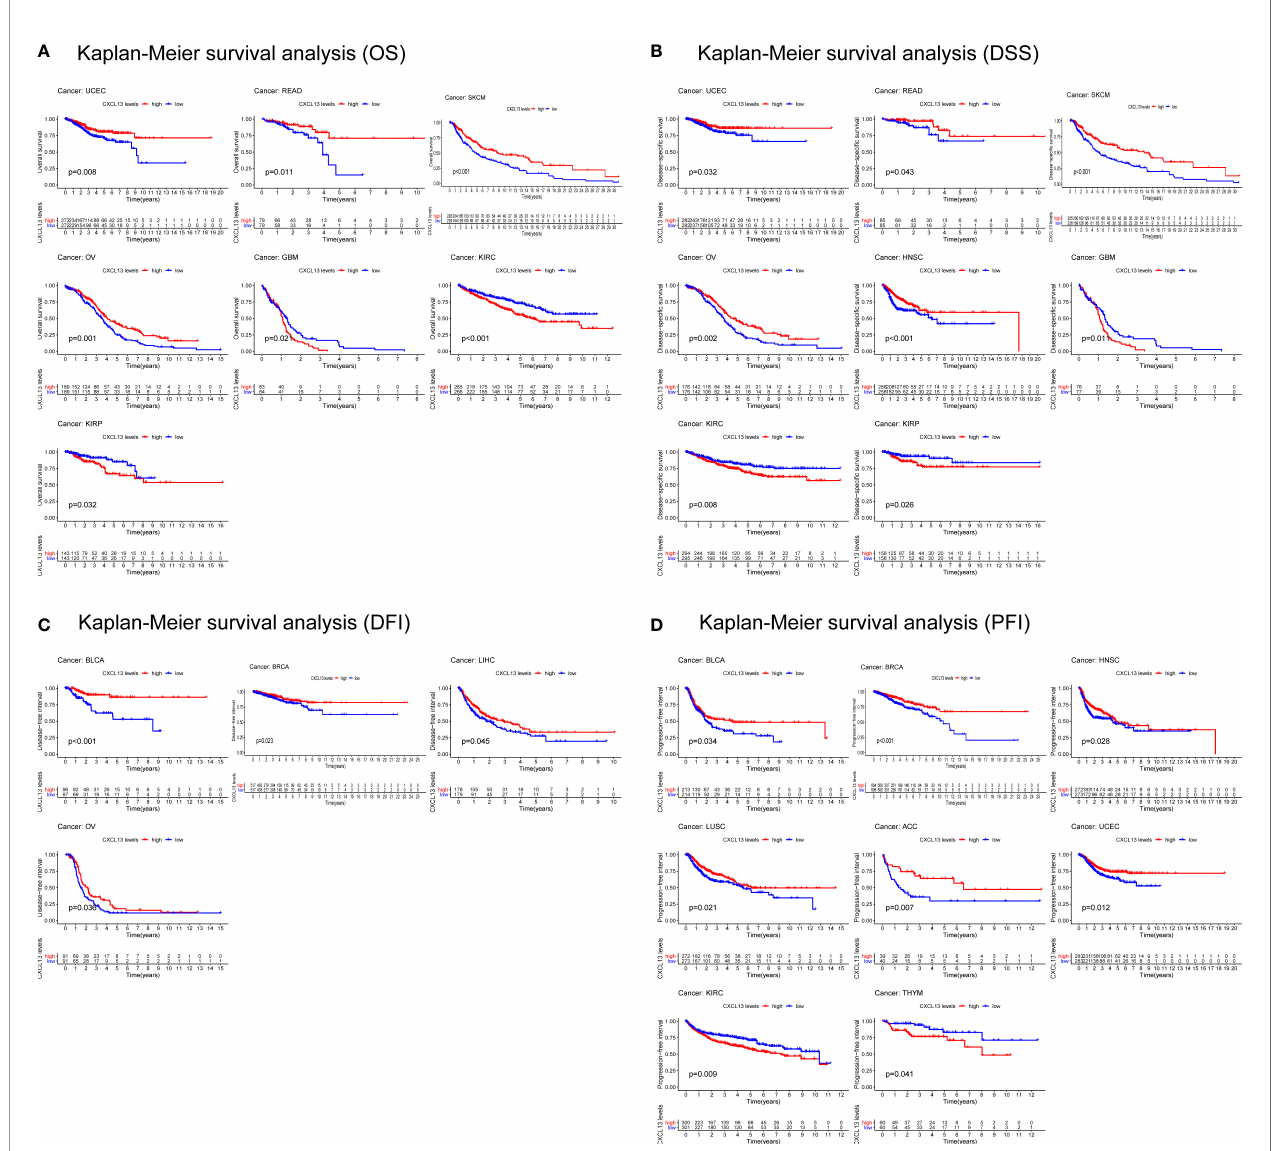
FIGURE 4 | Kaplan-Meier survival curves comparing the high and low expression of CXCL13 gene in various cancer types. (A) OS in 7 cancer types. (B) DSS in 8 cancer types. (C) DFI in 4 cancer types. (D) PFI in 8 cancer